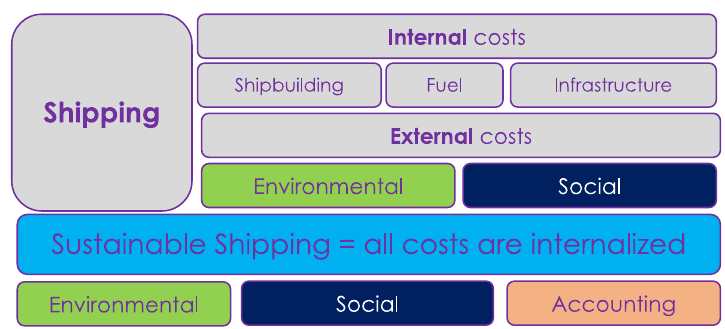
Fig. 1 The aim of the methodology (source: authors, costs are indicative—not to scale)